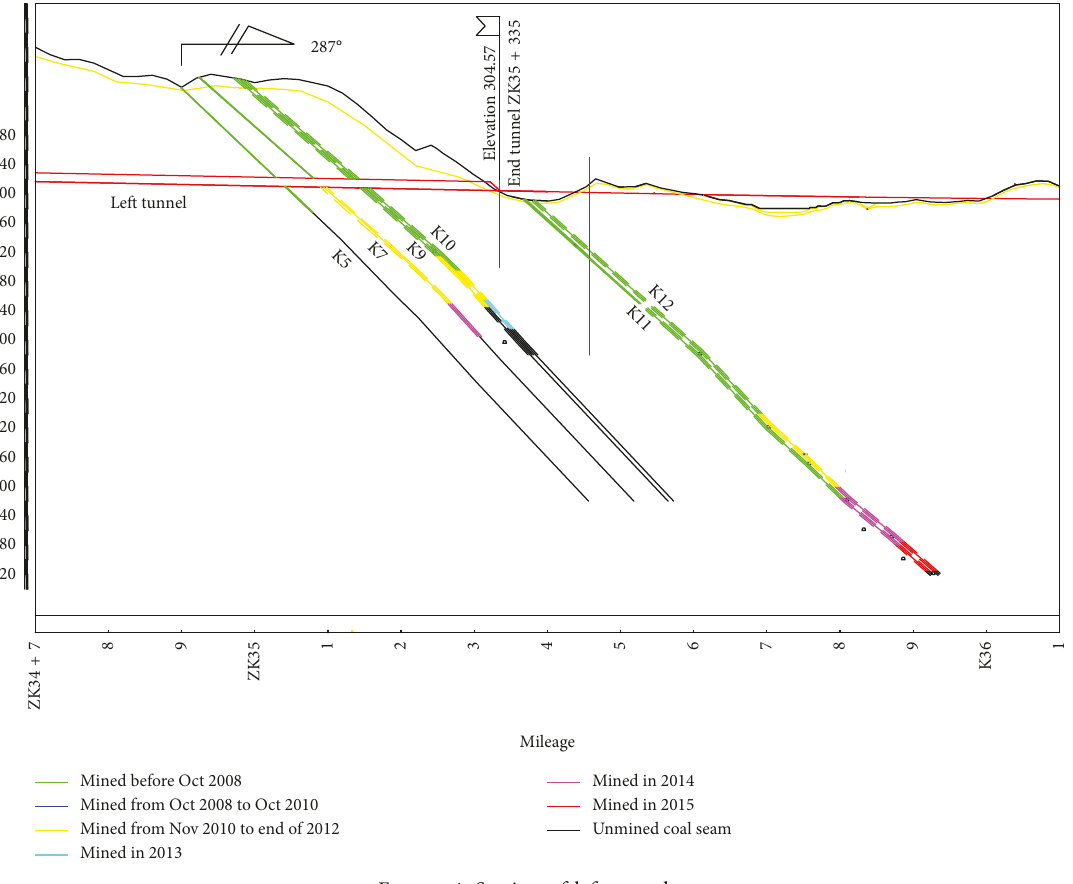
Figure 4: Section of left